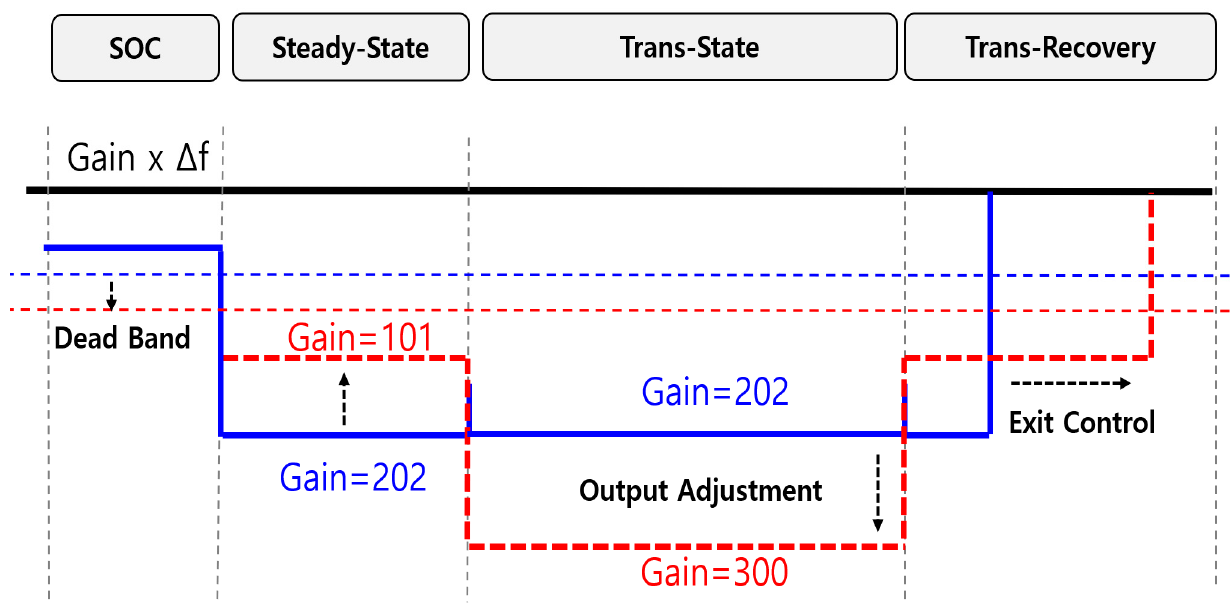
Figure 4. ESS parameter selection method.